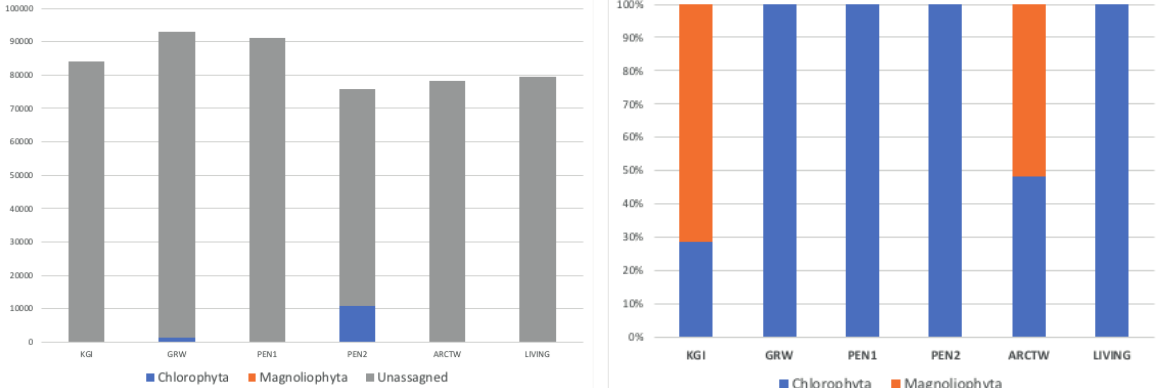
Figure 3. Histogram showing a) Tthe total number of reads obtained from each sampling site, including unassigned reads; and b) Percentage of groups represented, with the exclusion of unassigned